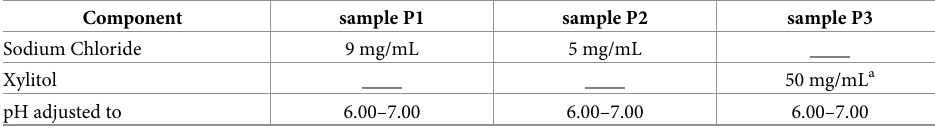
Table 2. Composition of samples used as diluents (samples without